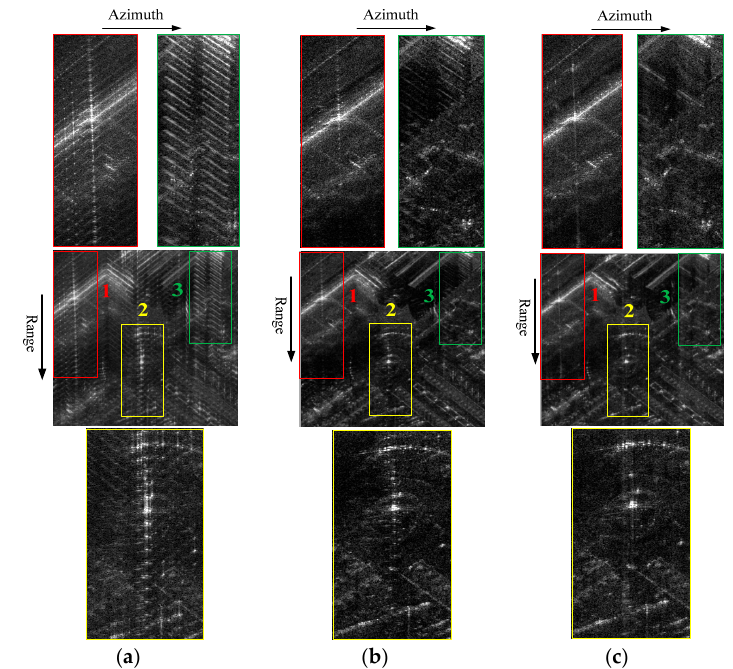
Figure 6. Stepped-frequency SAR image: ( a ) before GLS; ( b ) after GLS by GLPP; and ( c ) after GLS by the proposed method.